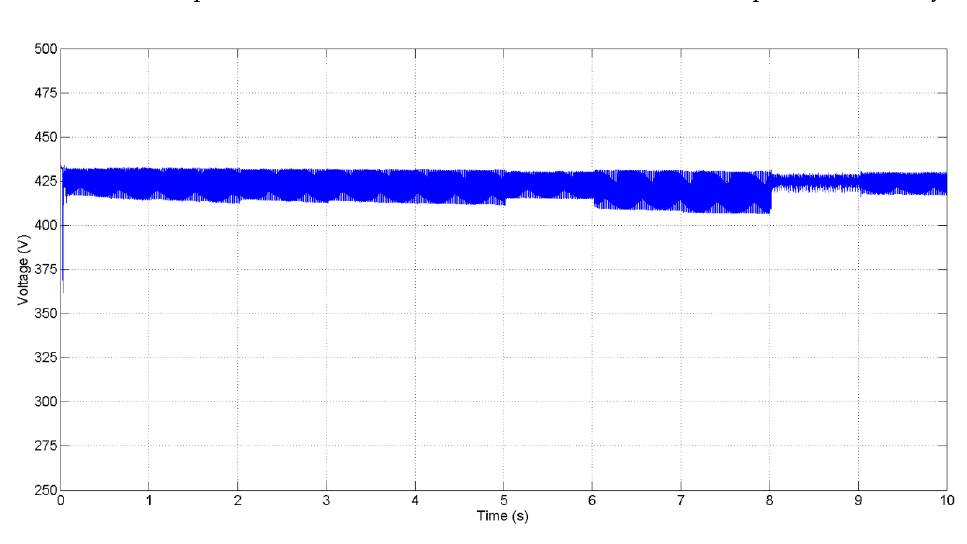
Figure 10. The voltage of the DC bus.